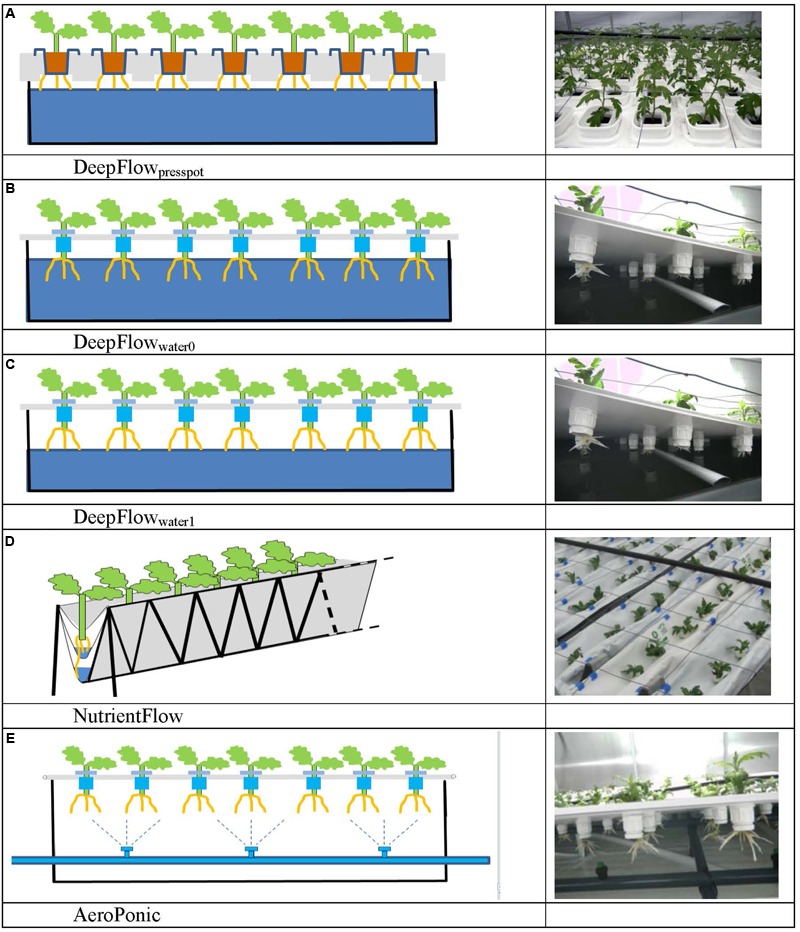
Schedules and photos of five treatments. DeepFlowpresspot, Deep Flow System with press pots, i.e., substrate-rooted cuttings (A). DeepFlowwater0, Deep Flow System water-rooted cuttings immersed in the nutrient solution surface (B). DeepFlowwater1, Deep Flow System, with water-rooted cuttings and solution surface at 1 cm below the basal end of the cuttings (C). NutrientFlow, Nutrient Flow System (D). AeroPonic, Aeroponic Mist System (E). NutrientFlow and AeroPonic both used water-rooted cuttings.